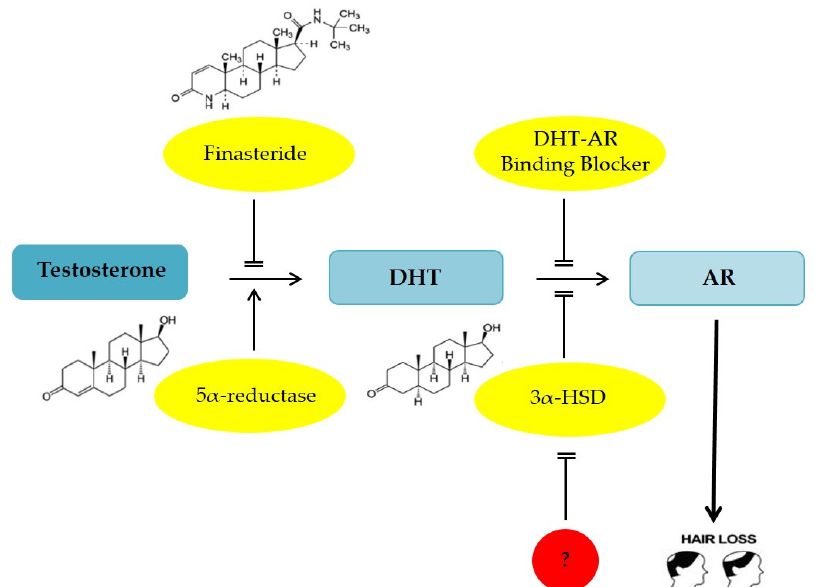
Figure 1. Schematic representation on the effect of the 5 α -reductase, dihydrotestosterone (DHT), 3 α -hydroxysteroid dehydrogenase (3 α -HSD), finasteride, and DHT-AR (androgen receptor) blockers actions for hair loss.